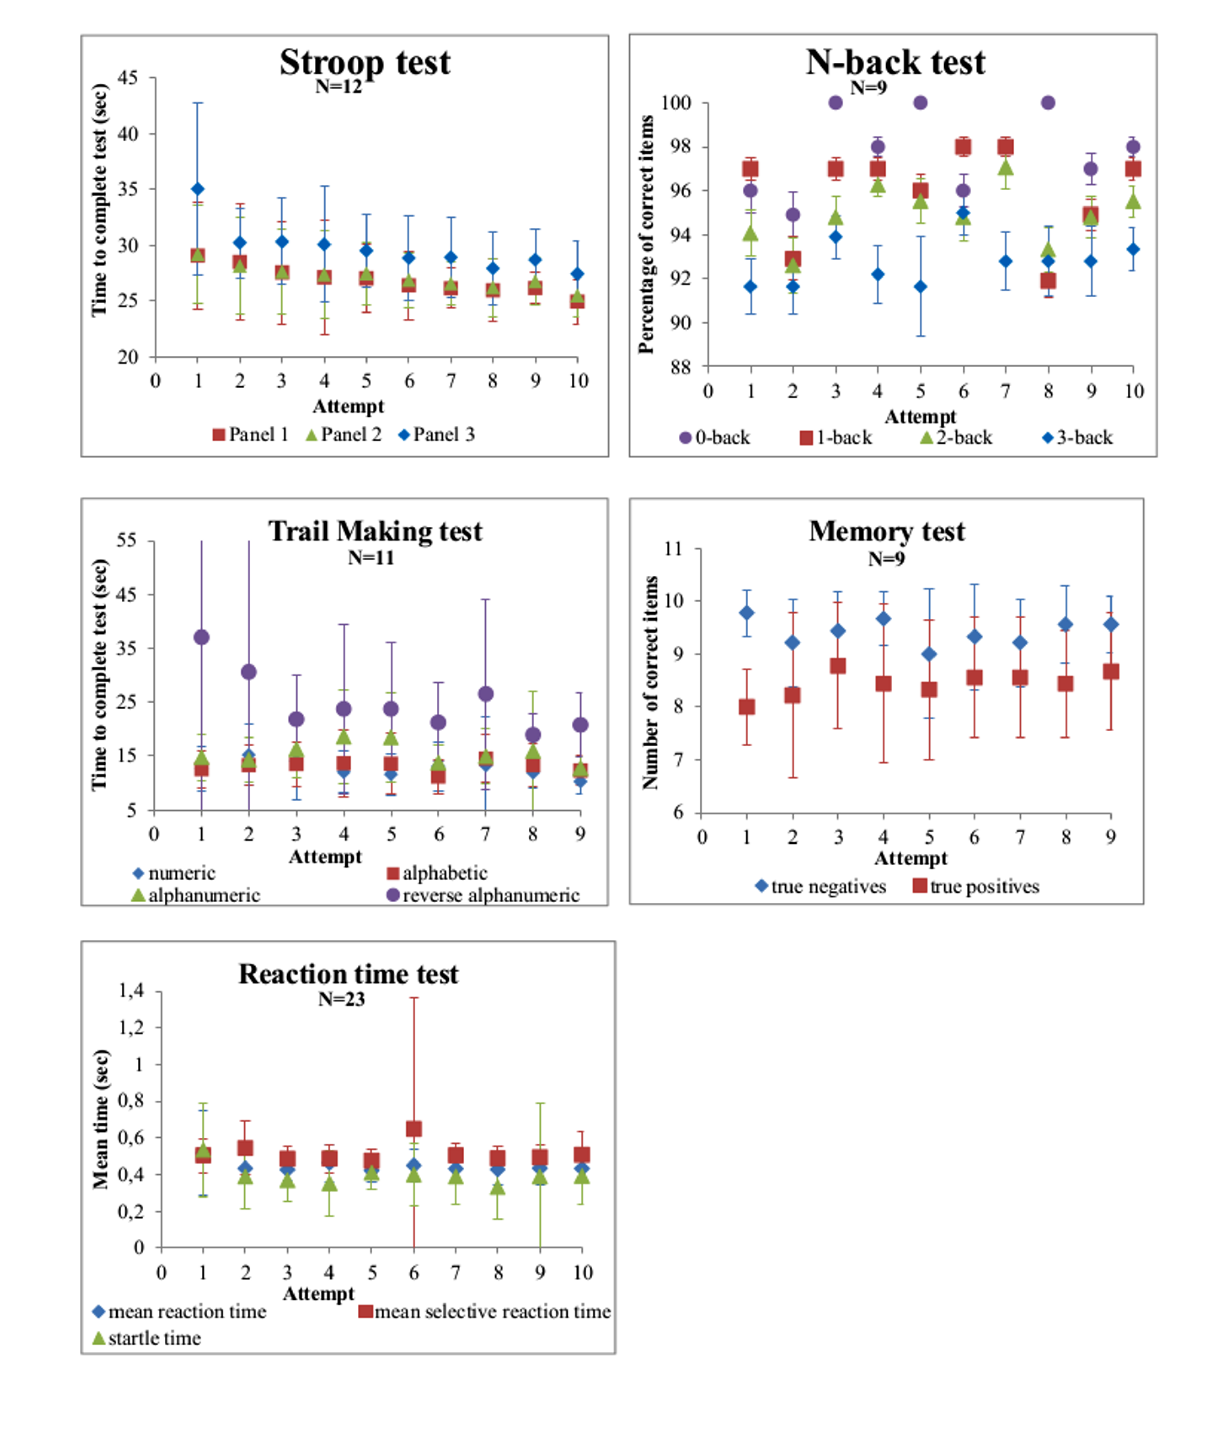
Figure 4. Effect of repeated cognitive tests on